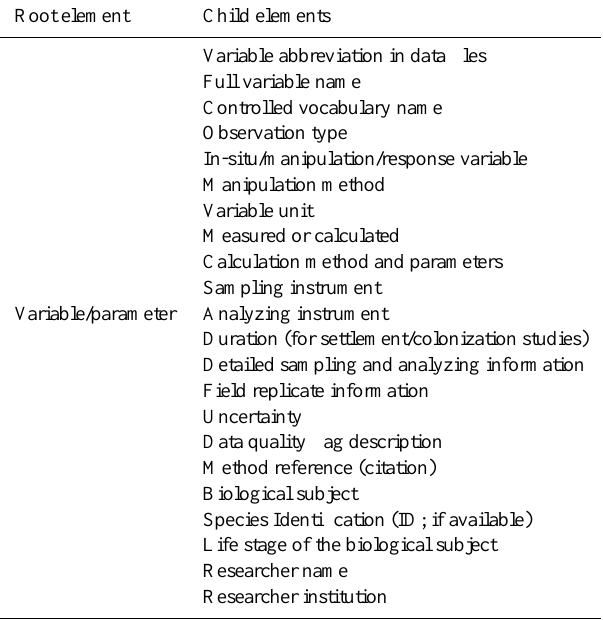
Table 2. Variable metadata section, with child metadata elements organized around the